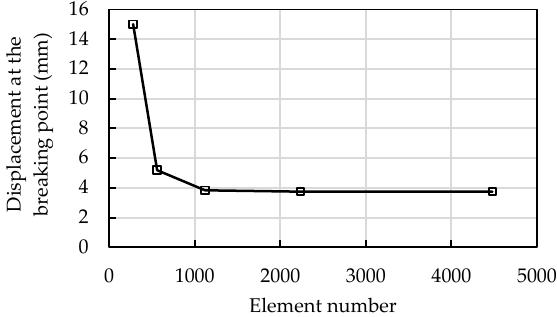
Figure 9. Mesh Convergence analysis.